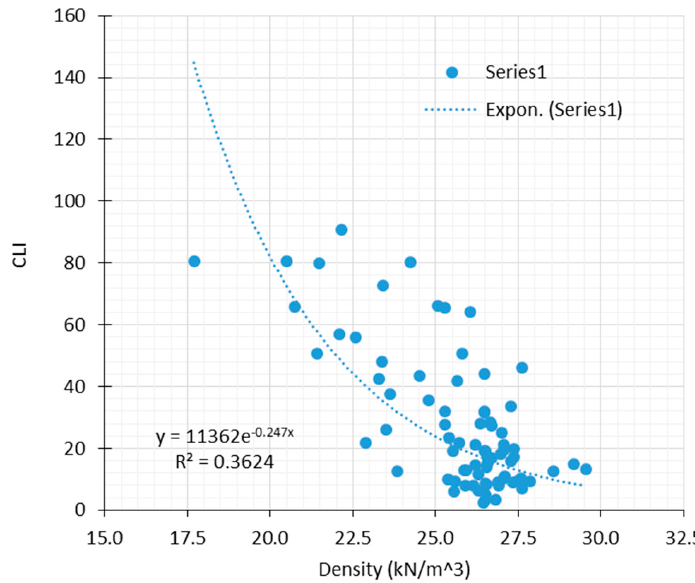
Figure 6. Relations between the density and CLI.